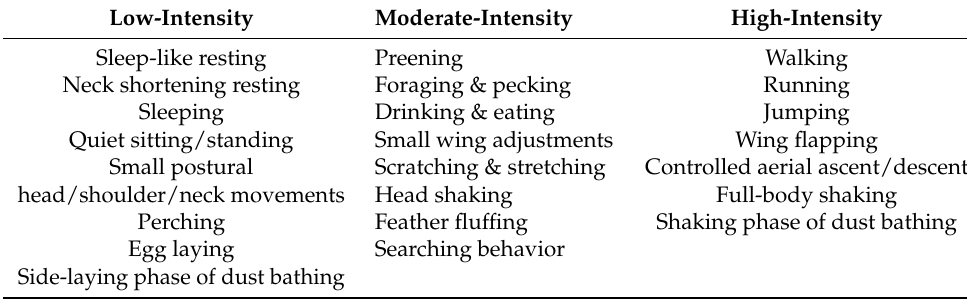
Table 2. Classification of physical activity of laying hens based on their intensity [26].